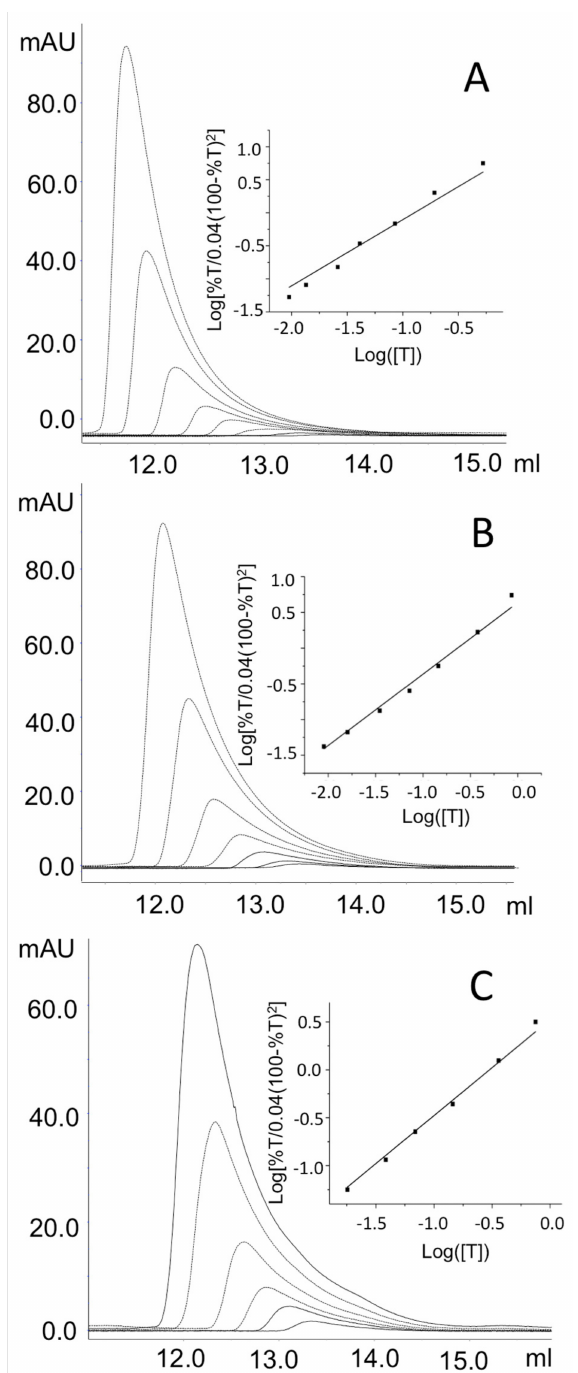
Figure 6. Analysis of the tetramer-dimer equilibrium of hOAT wild type, G51D and G121D variants by SEC. Chromatographic profiles obtained using a Superdex 200 10/30 Increase column equilibrated in HEPES 50 mM pH 8.0, NaCl 150 mM, PLP µ M of ( A ) OAT wild-type, ( B ) G51D variant and ( C ) G121D variant from 10 to 0.1 µ M protein concentration. Inset panels show the plots of log[%T/0.04(100 − %T) 2 ] vs. log([T]), when [%T/0.04(100 − %T) 2 ] = 1, [T] = K Dtet-dim . Chromatograms were analyzed by Unicorn v7.3 software (GE Healthcare, Chicago, IL, USA); The linear plots were obtained using Origin9 software (OriginLab, Northampton, MA,